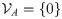
Two possible transmission trees and three possible pathogen phylogenies for a household outbreak.A, B, and C were infected in alphabetical order such that their infectious sets are VA={0}, VB={A}, and VC={A,B}. We have a single pathogen sequence from each person. The top shows the two possible transmission trees within the household: either A infected B and B infected C (left) or A infected B and C (right). The bottom shows the three rooted, bifurcating phylogenies linking pathogen sequences from A, B, and C. In each phylogeny, the possible hosts are written underneath each interior node and arrows indicate how each assignment of interior node hosts determines a transmission tree via Assumption 5.